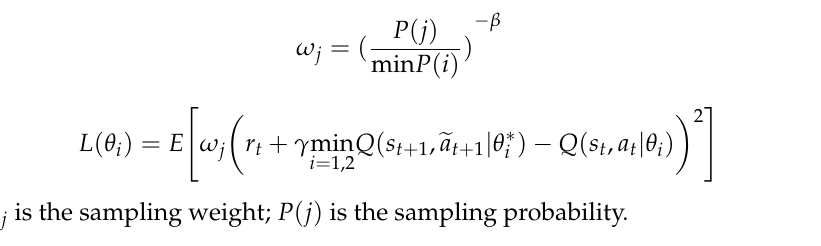
Algorithm 1. Calculation Process of the Strategy Based on PER ‐ TD3 Algorithm 1: initialization: actor estimation network